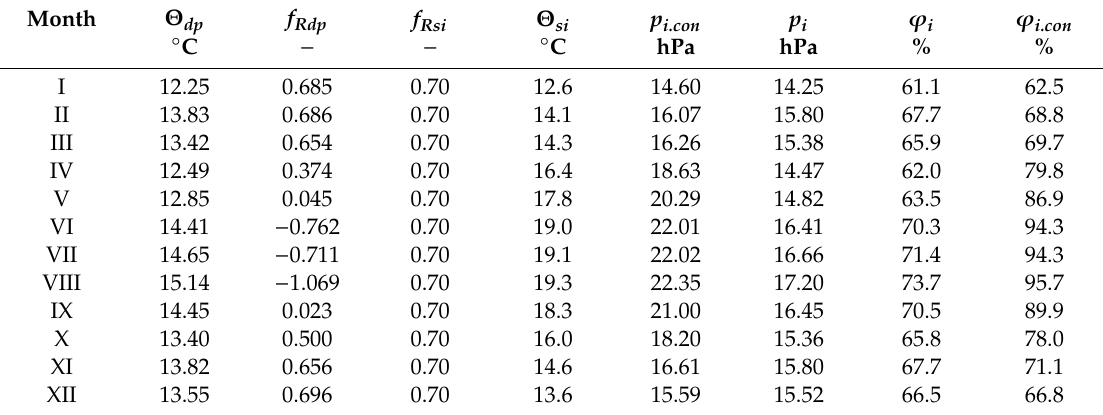
Table 7. Parameters for surface condensation characteristics for four methods.